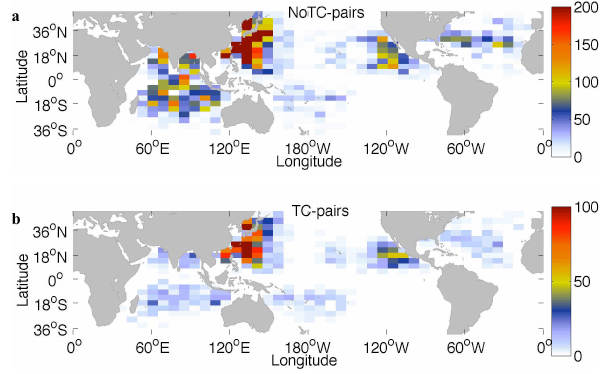
Figure B1. Counts of the (a) NoTC pairs and (c) TC-affected pairs in each 4 ◦ by 8 ◦ grid